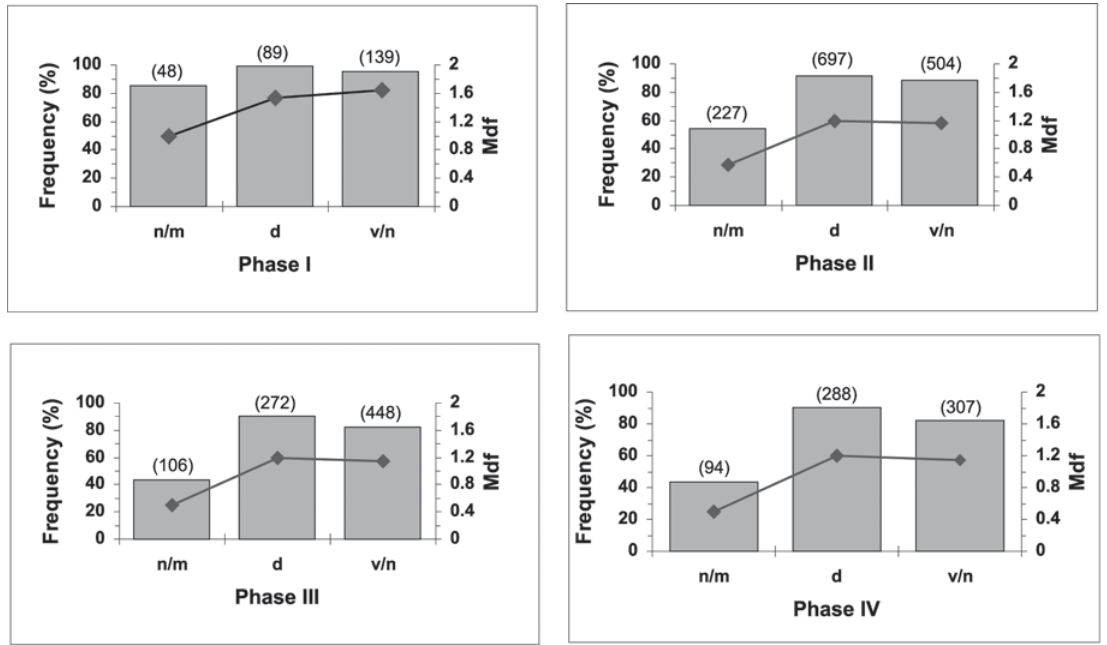
Fig. 2. Variations in the feeding activity of L. amblyrhynchus during formation of the reservatório de Corumbá, Goiás, Brazil. Frequency (%) = stomachs with food; MFd = medium fullness degree; n/m = nocturne matutinal; d = diurnal; v/n = vespertine